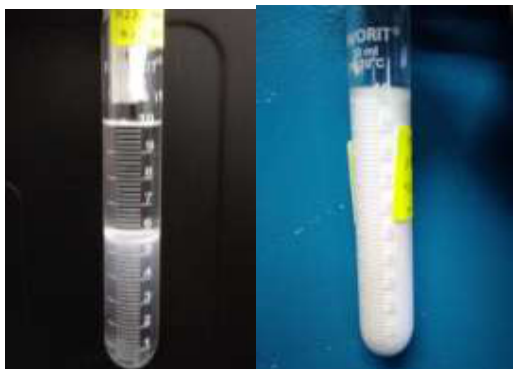
Figure 2: (a) Sample 5 (DOPC/SPAN 80-surfactant) and (b) Sample 3 (DOPC-surfactant)